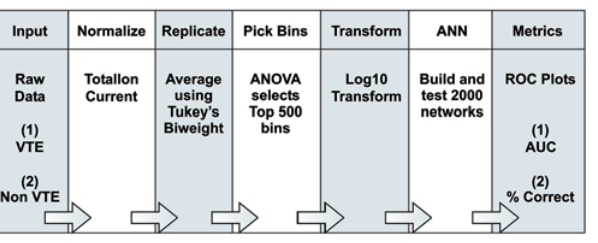
Figure 1. Computational pipeline used for analysis of direct MS data. Successive computational steps were performed using a pipeline to normalize, average and transform mass spectral data, perform ANN analysis and establish performance